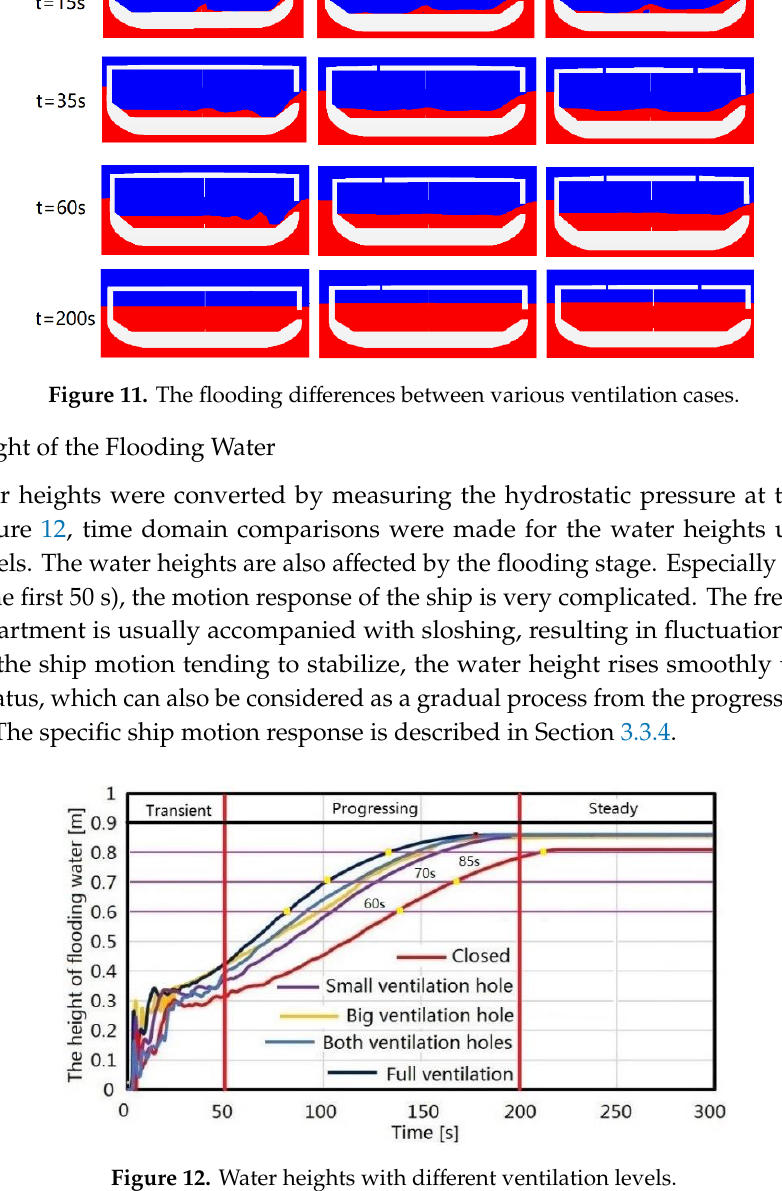
Figure 12. Water heights with different ventilation levels.